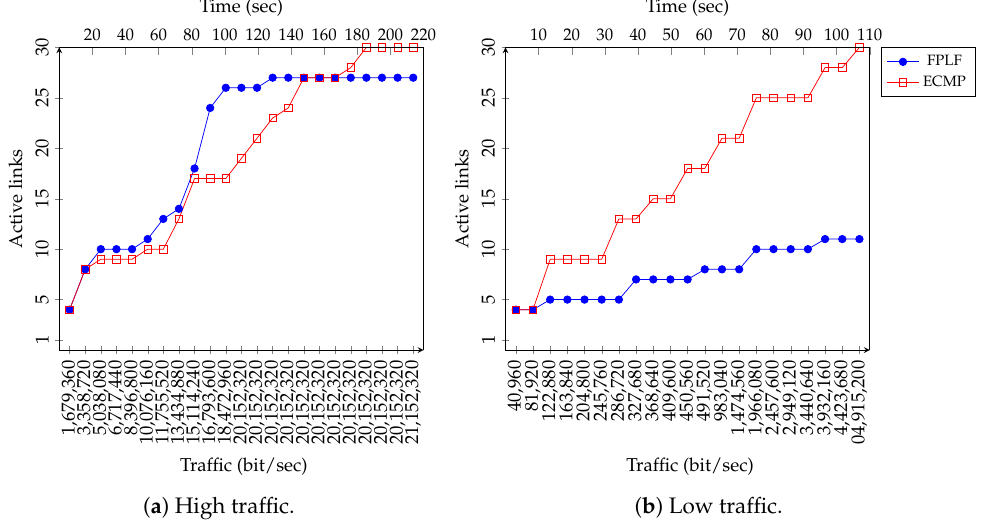
Figure 5. The DCN link usage under different traffic load